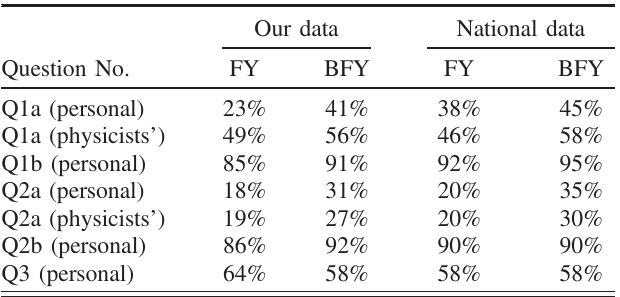
TABLE I. Percent of students with expertlike views in our data ( N ¼ 216 ) and national data ( N ¼ 7167 ). Our data National